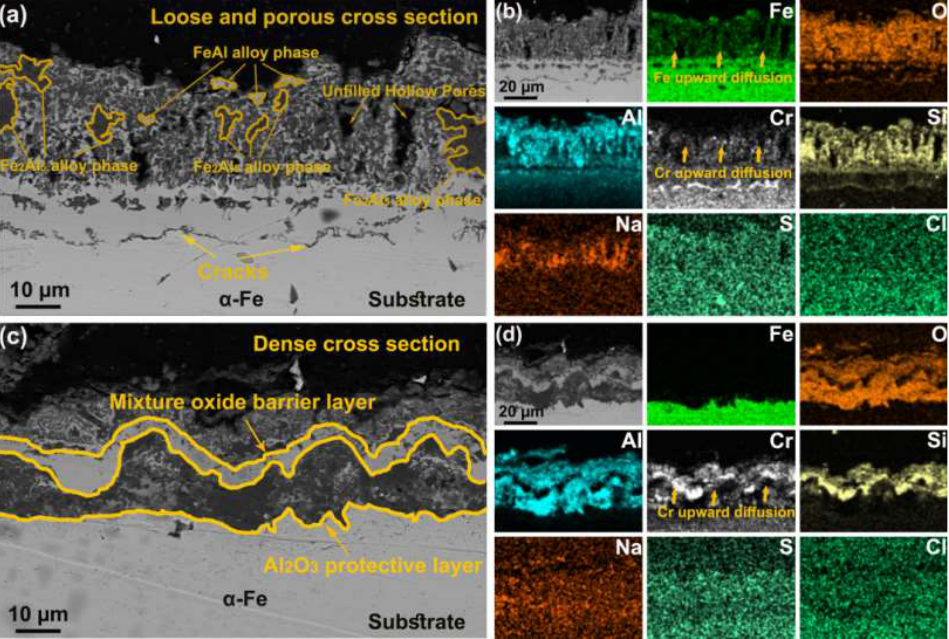
Figure 4. Cross-sectional SEM images and corresponding element mappings of all as-deposited coatings after 100 h salt corrosion test: ( a , b ) M1; ( c , d ) M2.